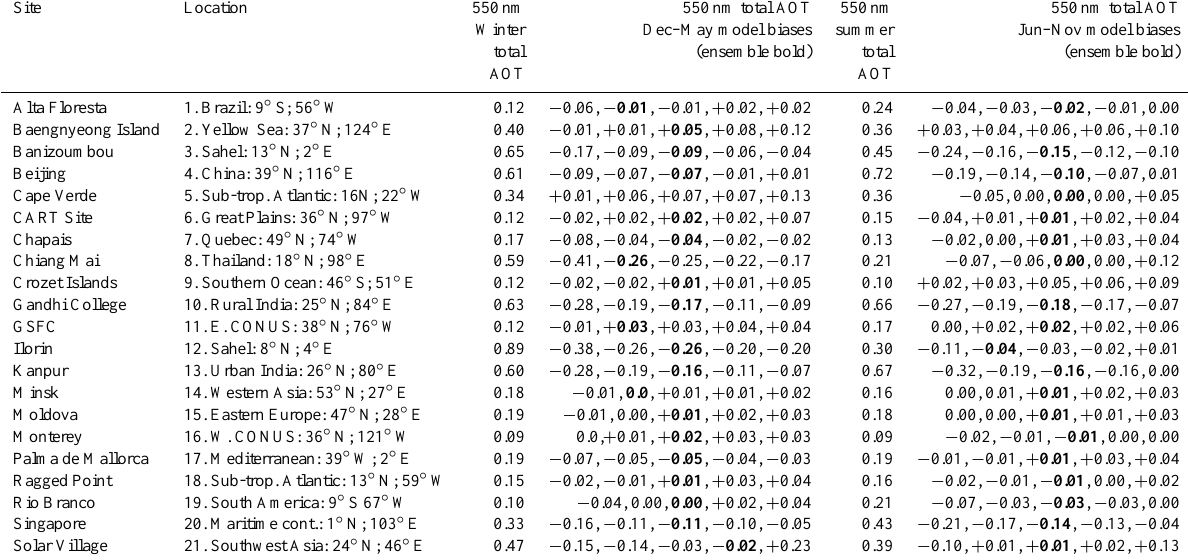
Table 1. List of + 1-day biases from study core AERONET sites. Included are the 550nm total AOTs. These are followed by list of model biases for the four core ICAP members listed sequentially low to high for each site. The ICAP-MME ensemble mean bias is bold. Site